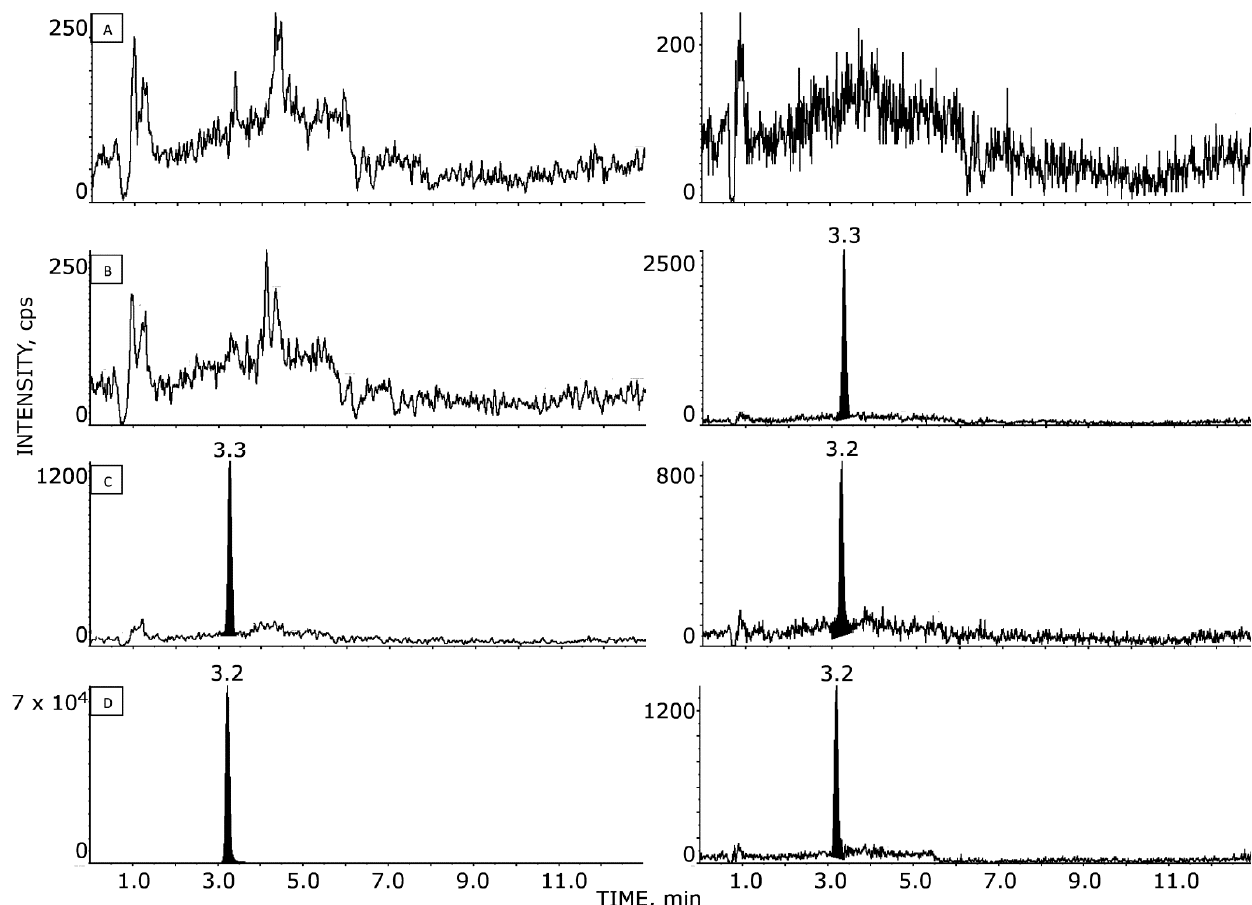
Figure 2. HPLC–MS/MS chromatograms of NAZ in murine plasma: ( A ) blank sample; ( B ) blank sample with added IS; ( C ) NAZ at the LLOQ (i.e., 1 ng/mL); ( D ) NAZ and IS of an extracted sample 1 h after the last drug administration; the measured concentration corresponds to 2330 ng/mL.